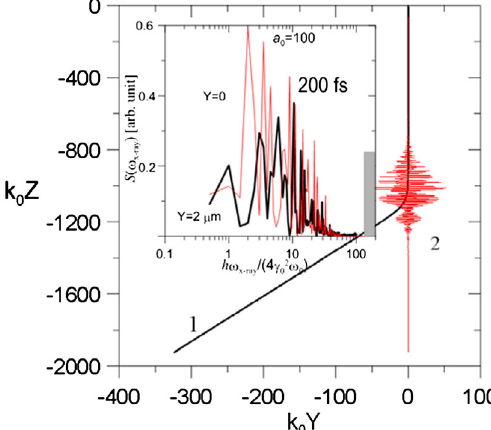
FIG. 5. Trajectory and backward spectra (insert) for a 0 ¼ 100 and τ ¼ 200 fs for a collision with a 2 μ m transverse shift (black curves) and for a head-on collision (red curves). Since the trajectory for the head-on collision is a straight line we give instead the pulse field evolution for this case (red curve).